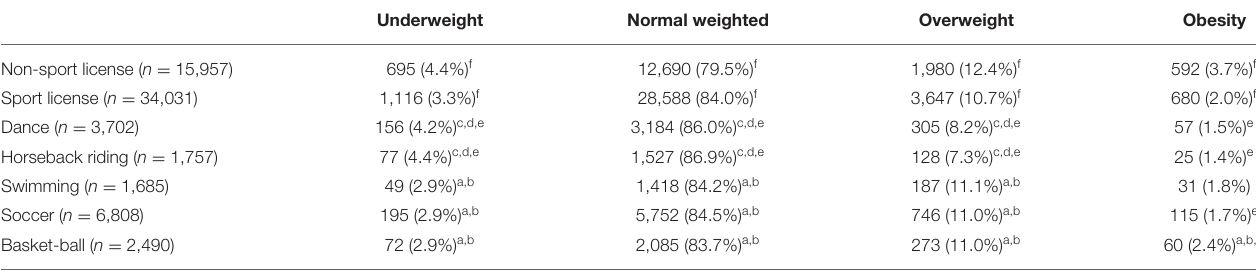
TABLE 5 | Prevalence in each class of body mass index according to sports. Underweight Normal